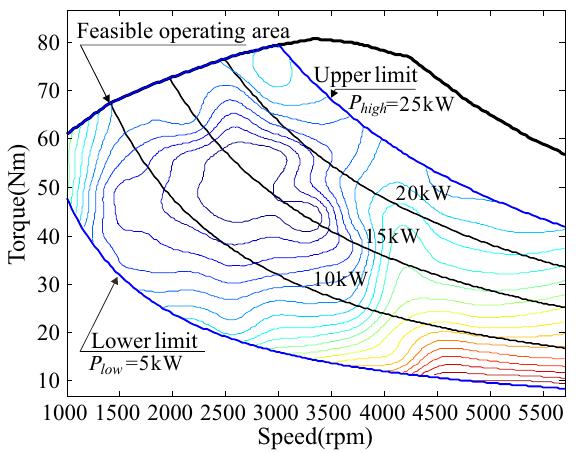
Figure 4. Feasible operating area when P cmd ∈ [ 5,25 ]